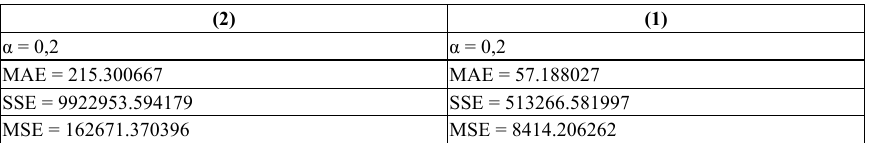
Table 3. Comparison of Alpha 0,2